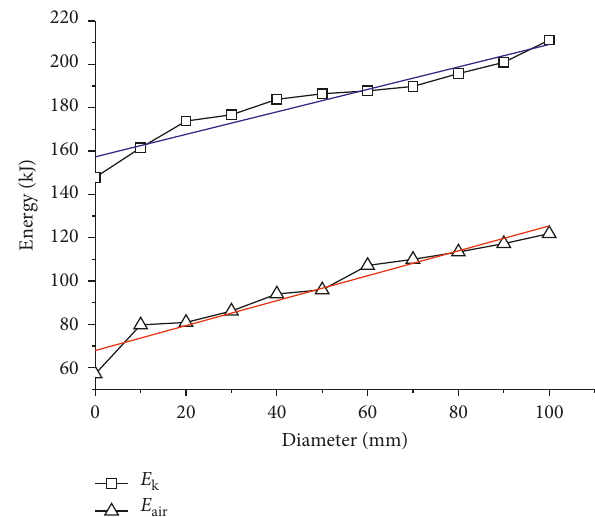
Figure 18: Changing curve of maximum kinetic energy and air energy with different vent diameters.